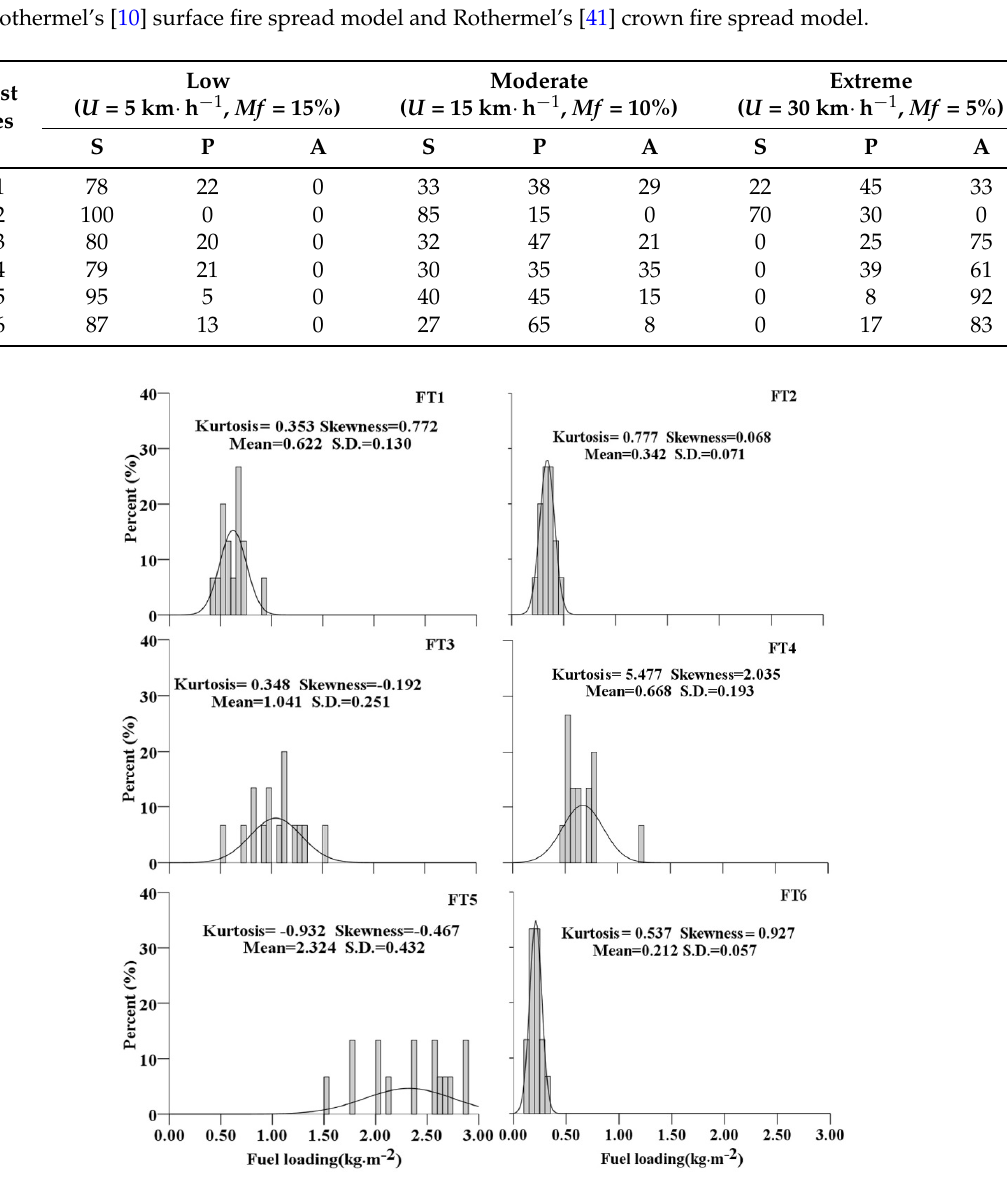
The number in parentheses is the standard deviation. Table 3. Percent of fire types (surface (S), Passive crown fire (P) and Active crown fire (A) from simulation of different fire weather scenarios at 10 m wind speed ( U ), and fuel moisture content ( M f ) for the six forest types. Fire types were derived according to Alvarez [29] fire spread criteria and